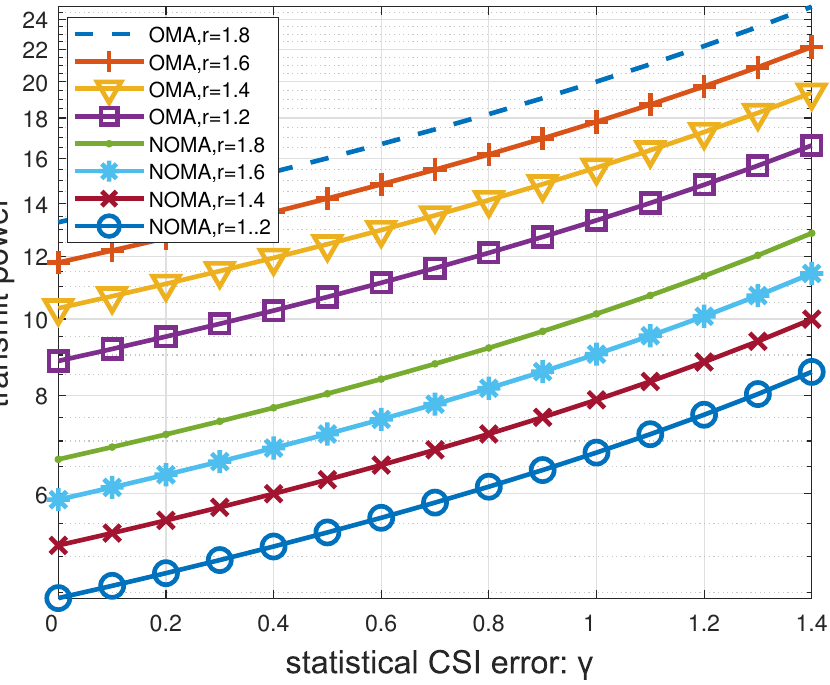
Figure 6. Transmit power versus statistical CSI error, when L = 2 , ρ = 0.05.